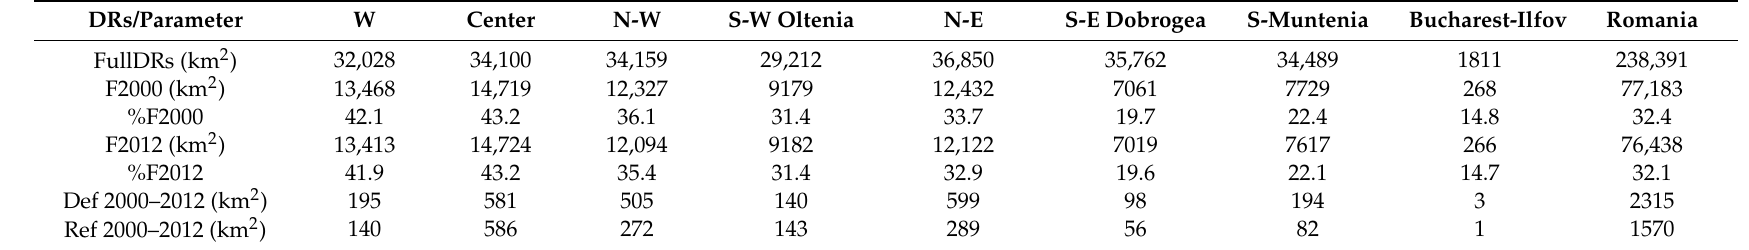
Table 2. Characteristics of forest resources per development region during the period